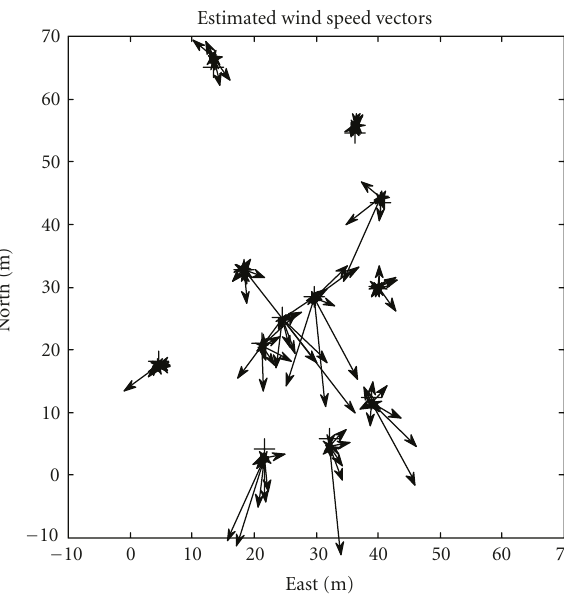
Figure 13: Estimate of wind speed